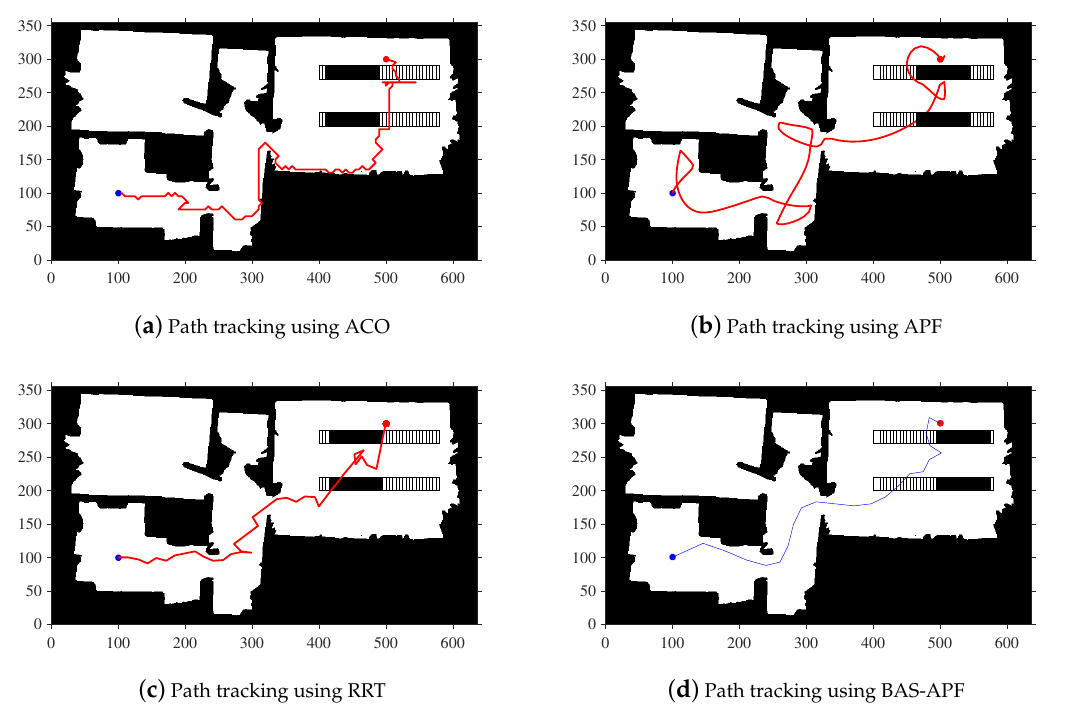
Figure 8. Comparative simulation results on a map with horizontal dynamic